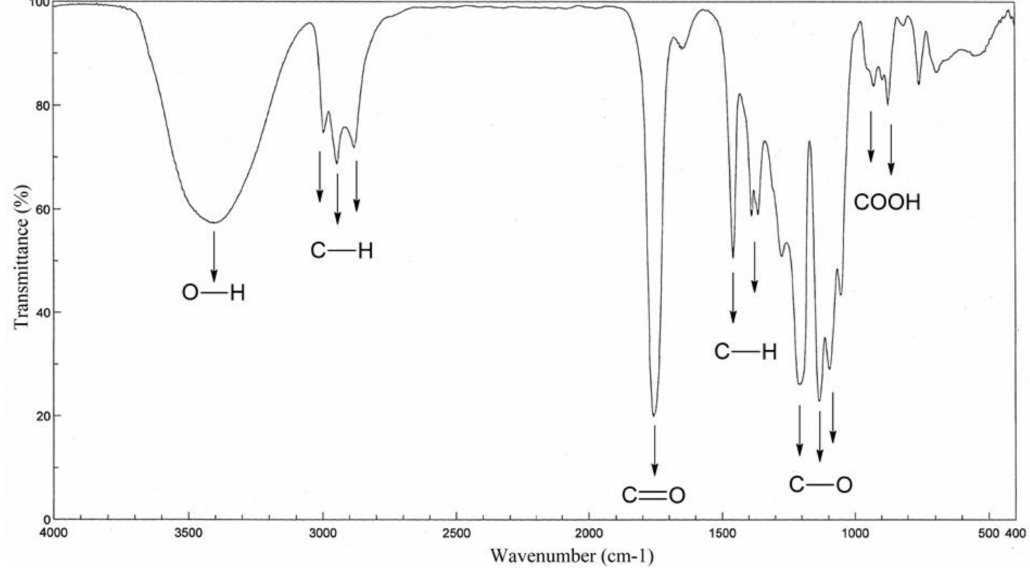
Figure 3. IR spectra of